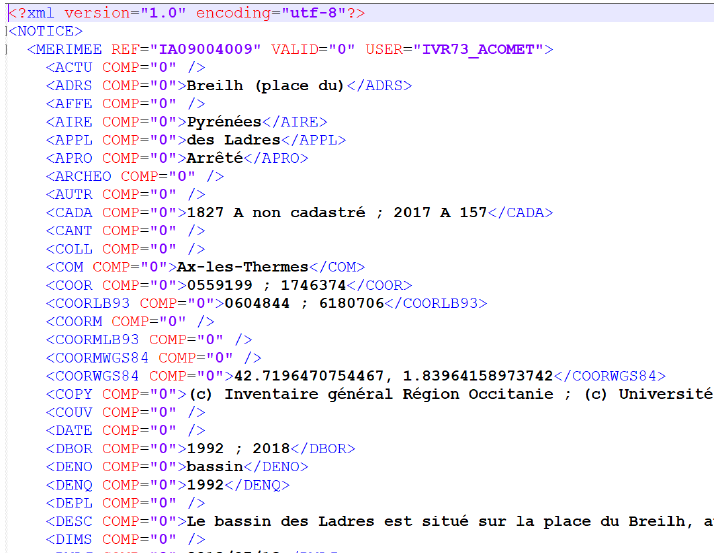
Figure 3. XML export file sample.